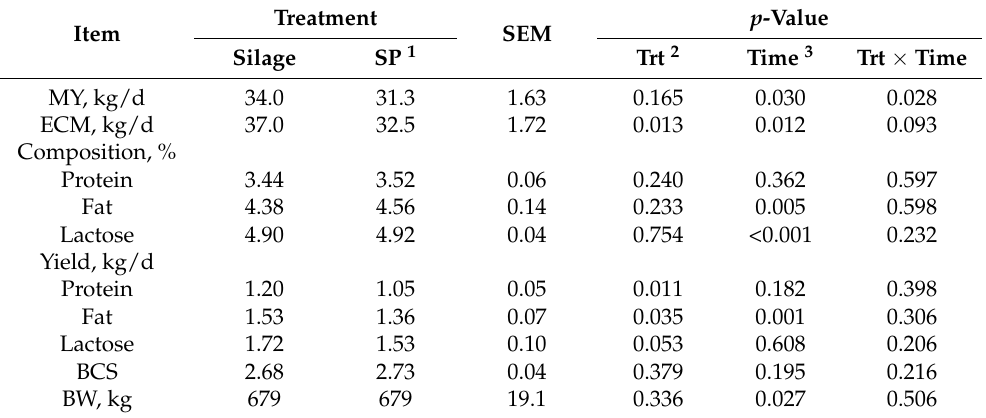
Table 3. Milk yield (MY), energy-corrected milk (ECM) yield, milk composition, body condition score (BCS) and body weight (BW) of cows fed the experimental diets ( n = 36).